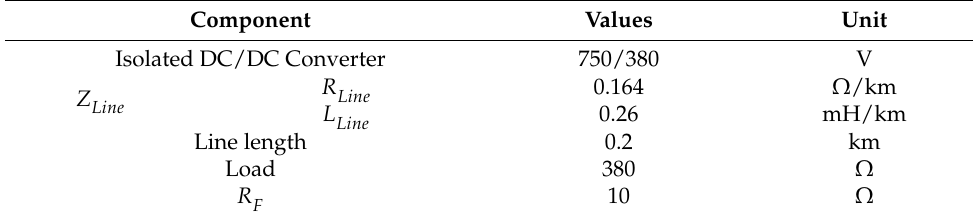
Table 6. Ratio of the body resistance and body resistance according to the current path.